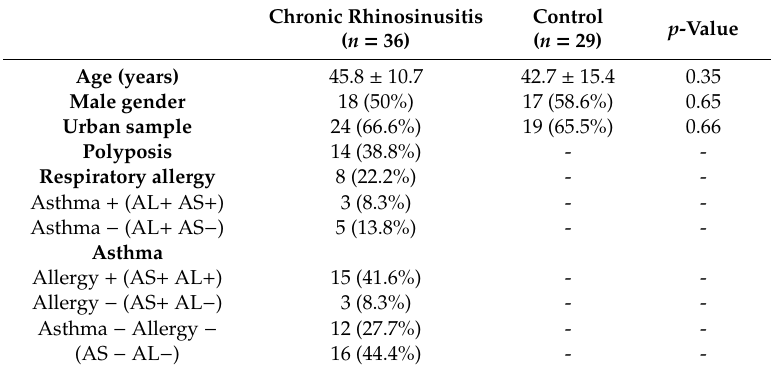
Table 1. General characteristics of the patients included in the study. AL—allergy, AS—asthma.